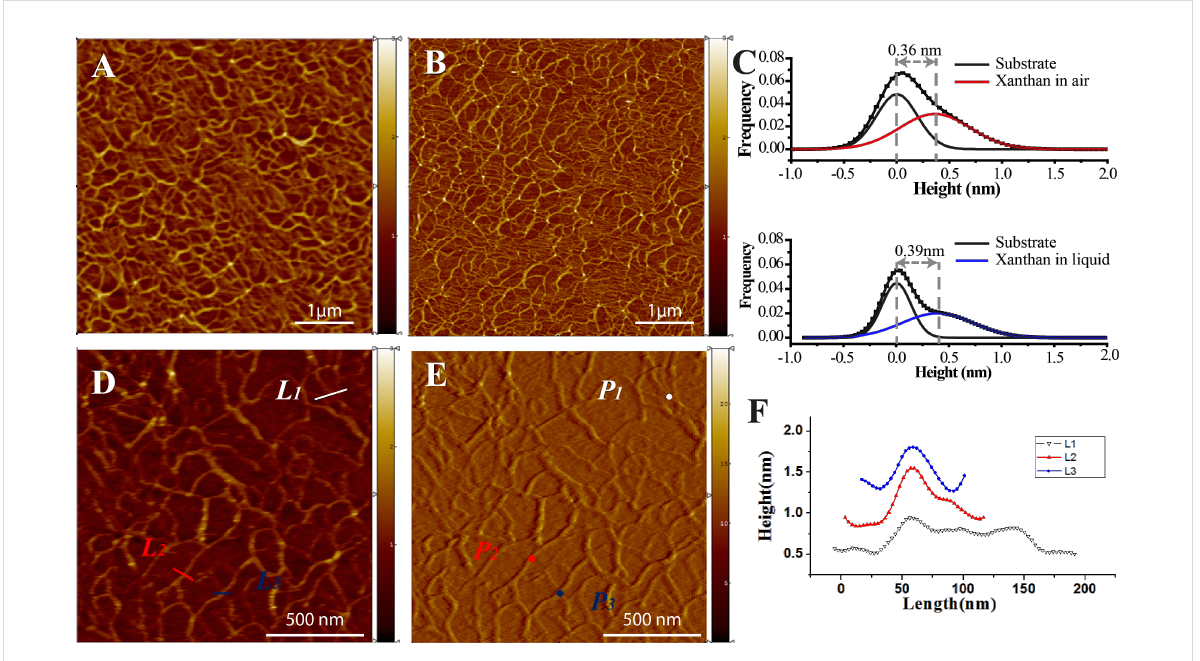
Figure 1: AFM images of xanthan scaffold A) in air, B) in isopropanol. C) Height histograms of xanthan scaffold in air and in isopropanol, respectively. D) Topography image in isopropanol. E) Corresponding deflection image in isopropanol. F) Line profiles that correspond to the marks L 1 , L 2 and L 3 in Figure